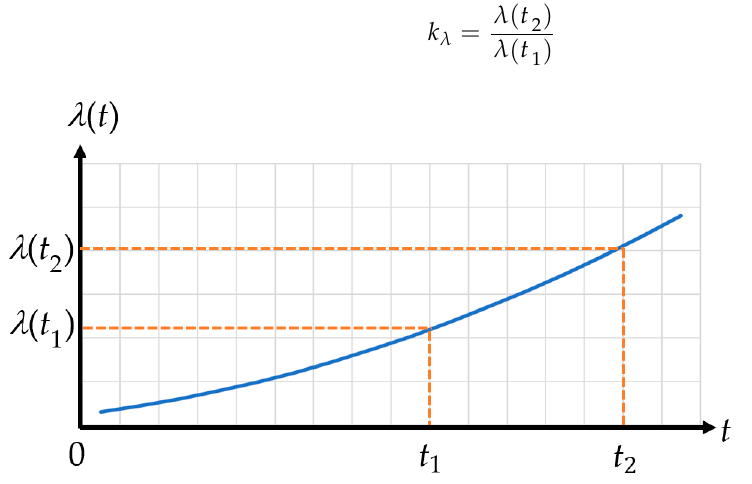
Figure 1. Increasing failure rate, k λ > 1 .